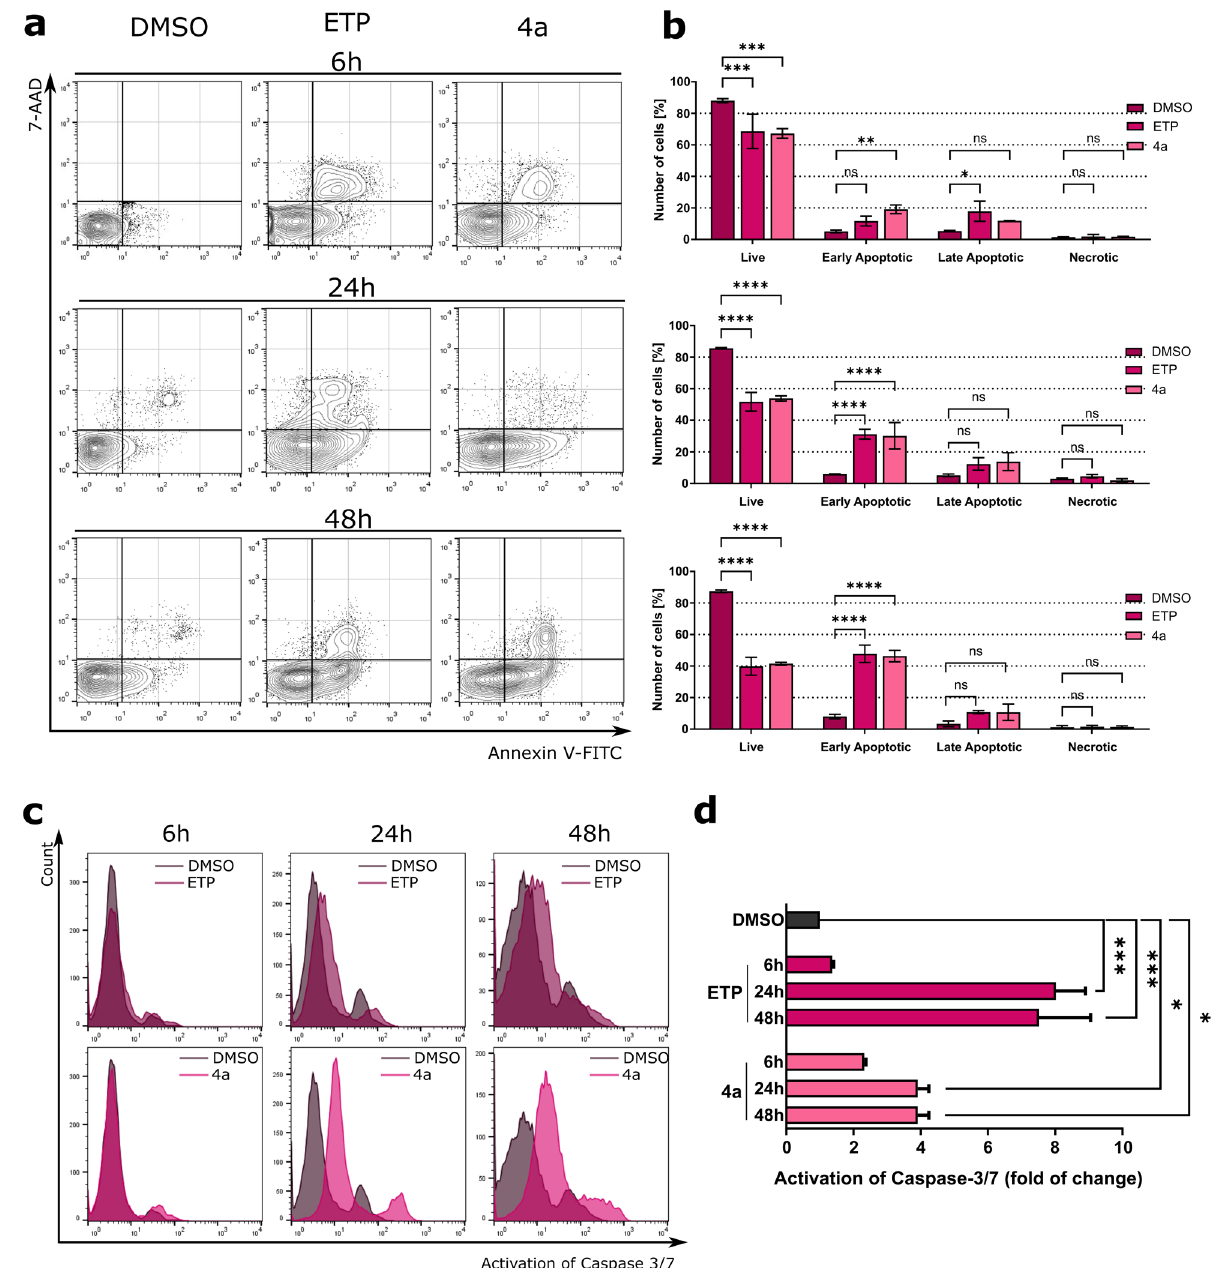
Figure 5. Detection of apoptosis by flow cytometry. ( a ) Representative dot plots after treatment of A549 cells with 4a . ( b ) Quantitation of A549 cells after Annexin V-FITC/7-AAD staining. ( c ) Detection of caspase-3/7 activation in 4a -treated A549 cells, presented as representative histograms. ( d ) Quantification of analysis from ( c ). Data represent the mean ± SEM of n = 3 independent experiments. * p < 0.01, ** p < 0.001, *** p < 0.0001, and **** p <